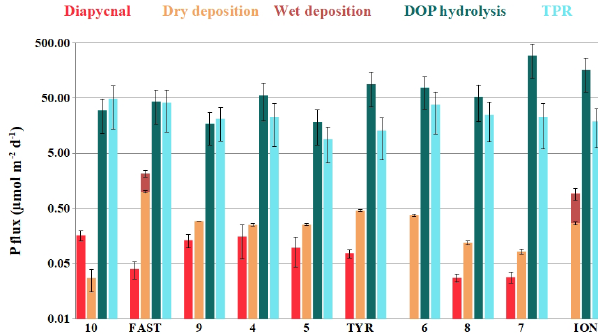
Figure 4. Phosphate fluxes (µmolm − 2 d − 1 , logarithmic scale) sup- plying the mixed layer across the study stations arranged longitu- dinally: diapycnal fluxes inside the PDL, total (dry plus wet) at- mospheric deposition and DOP in situ hydrolysis. Estimated total phosphate requirements (TPRs) are depicted for comparison (see text and Tables S1 and S2 for